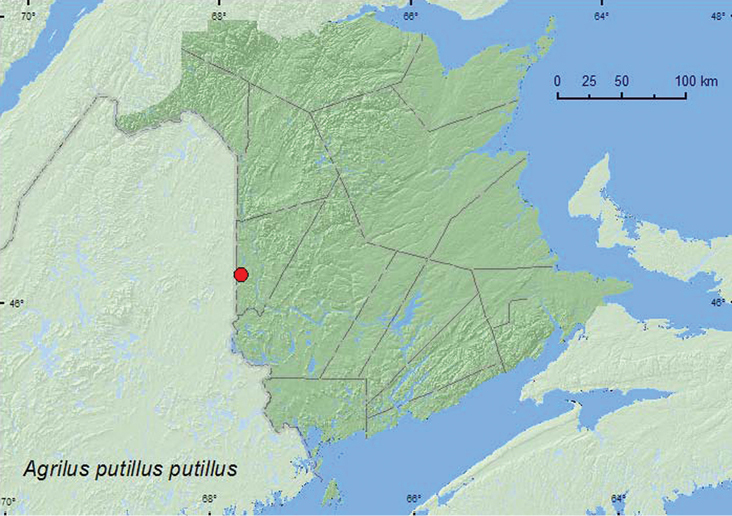
Collection localities in New Brunswick, Canada of Agrilus putillus putillus.